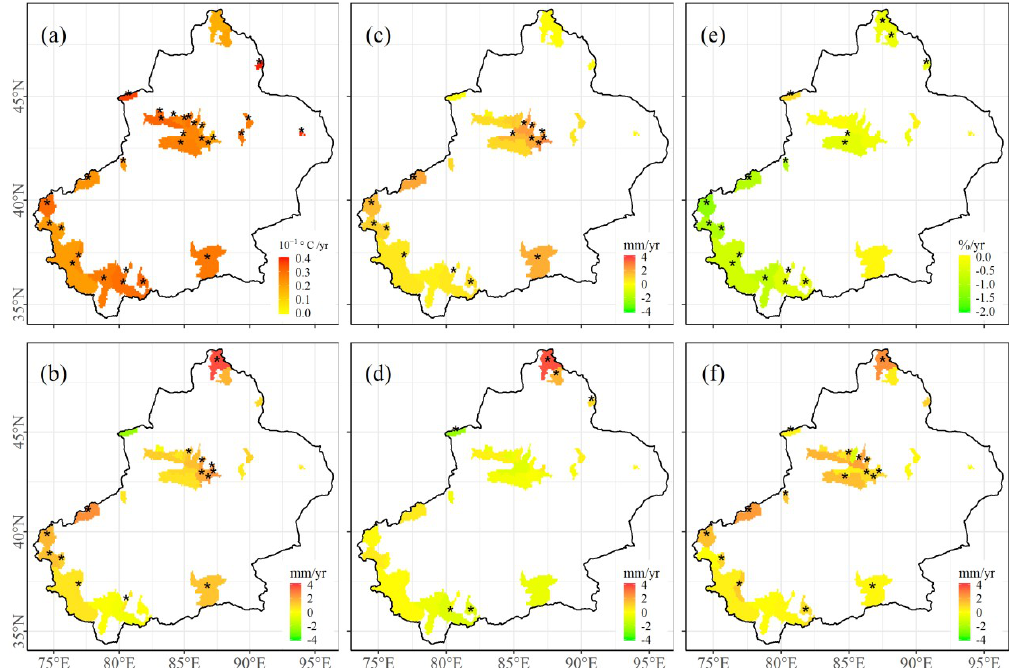
Figure 4. The spatial–temporal distribution of air temperature (10 − 1 × ◦ C/yr, ( a )), precipitation (mm/yr, ( b )), rainfall (mm/yr, ( c )), snowfall (mm/yr, ( d )), snow cover fraction (SCF) (%/yr, ( e )), and runoff (mm/yr, ( f )) at 33 catchments during 1970–2010. The star symbol (*) indicate trends are significant at the 95% confidence level ( p < 0.05).